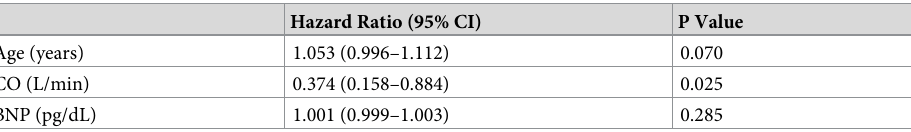
Table 3. Multivariate analysis of selected baseline